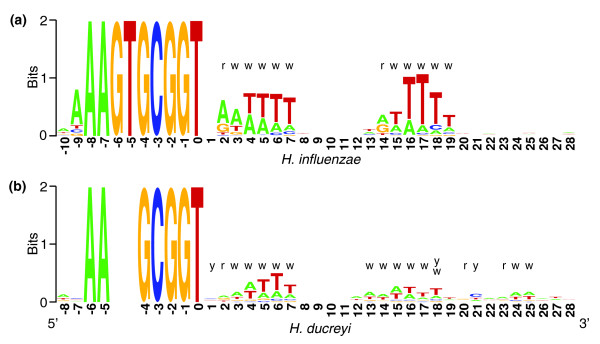
Extended motif for H. ducreyi and H. influenzae. (a) A sequence logo [26,27] created from the regions surrounding occurrences of USS motifs in H. influenzae. Position +1 is the first position following the USS motif. The previously reported extended motif is shown above the letters. (b) A sequence logo created from the regions surrounding occurrences of the conjectured USS motif in H. ducreyi. A gap of two nucleotides has been introduced to align the H. ducreyi motif with the H. influenzae motif. (An alternative alignment places position -4 in H. ducreyi across from position -6 in H. influenzae.) Examining the frequencies, we can derive a consensus pattern as follows. We mark a position with a 'w' if more than 70% of the occurrences contain an A or a T (expected frequency of an A or T = 60%). We mark a column with a 'y' or 'r' if more than 60% of the occurrences have a T or a C (for 'y') or A or a G (for 'r'). The expected frequency for either case is 50%. The 'rwwwwnnnn' from positions +2 to +11 matches the previously identified extended motif for H. influenzae, though the rwwww motif is not as clear. The subsequent 'nnrwwwww' from the extended H. influenzae motif is not exactly matched in H. ducreyi but there is a general bias toward A and T residues extending to about +25.